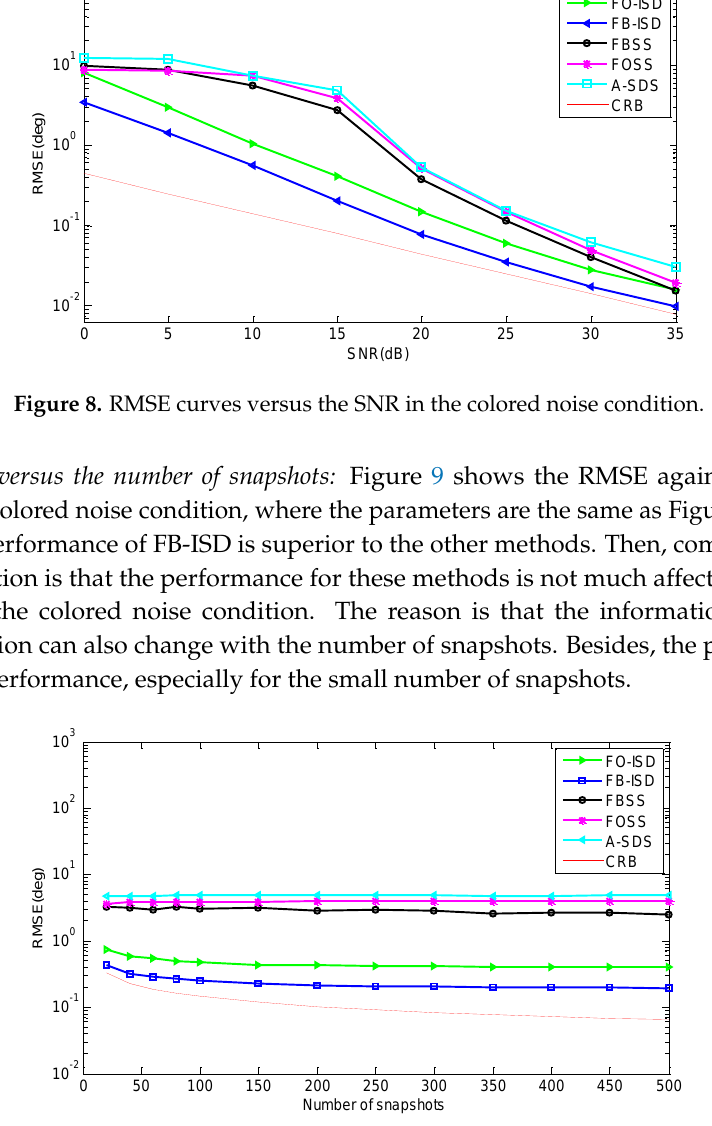
Figure 9. RMSE curve versus the number of snapshots in the colored noise